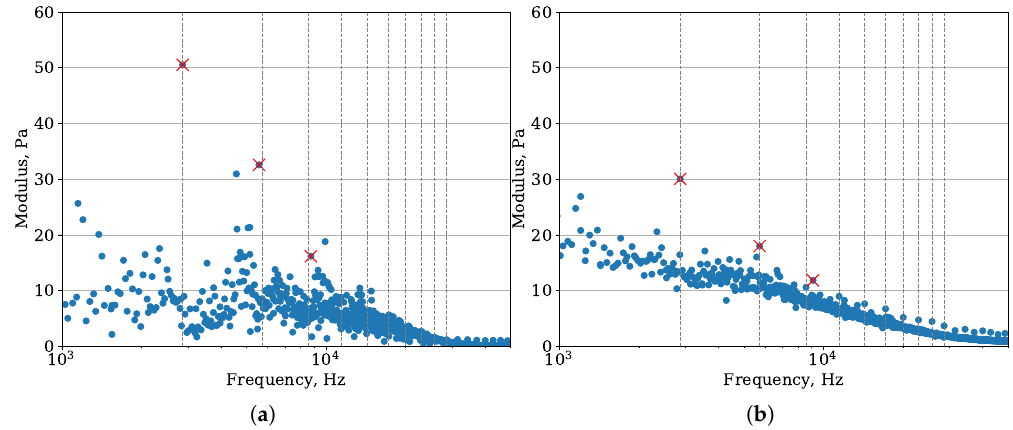
Figure 13. Dynamic mode decomposition(DMD) amplitude spectra: ( a ) upstream volume, ( b ) downstream volume. Vertical grey dashed lines show the blade passing frequencies. Red crosses indicate the most energetic modes around first three blade passing frequencies (BPFs).